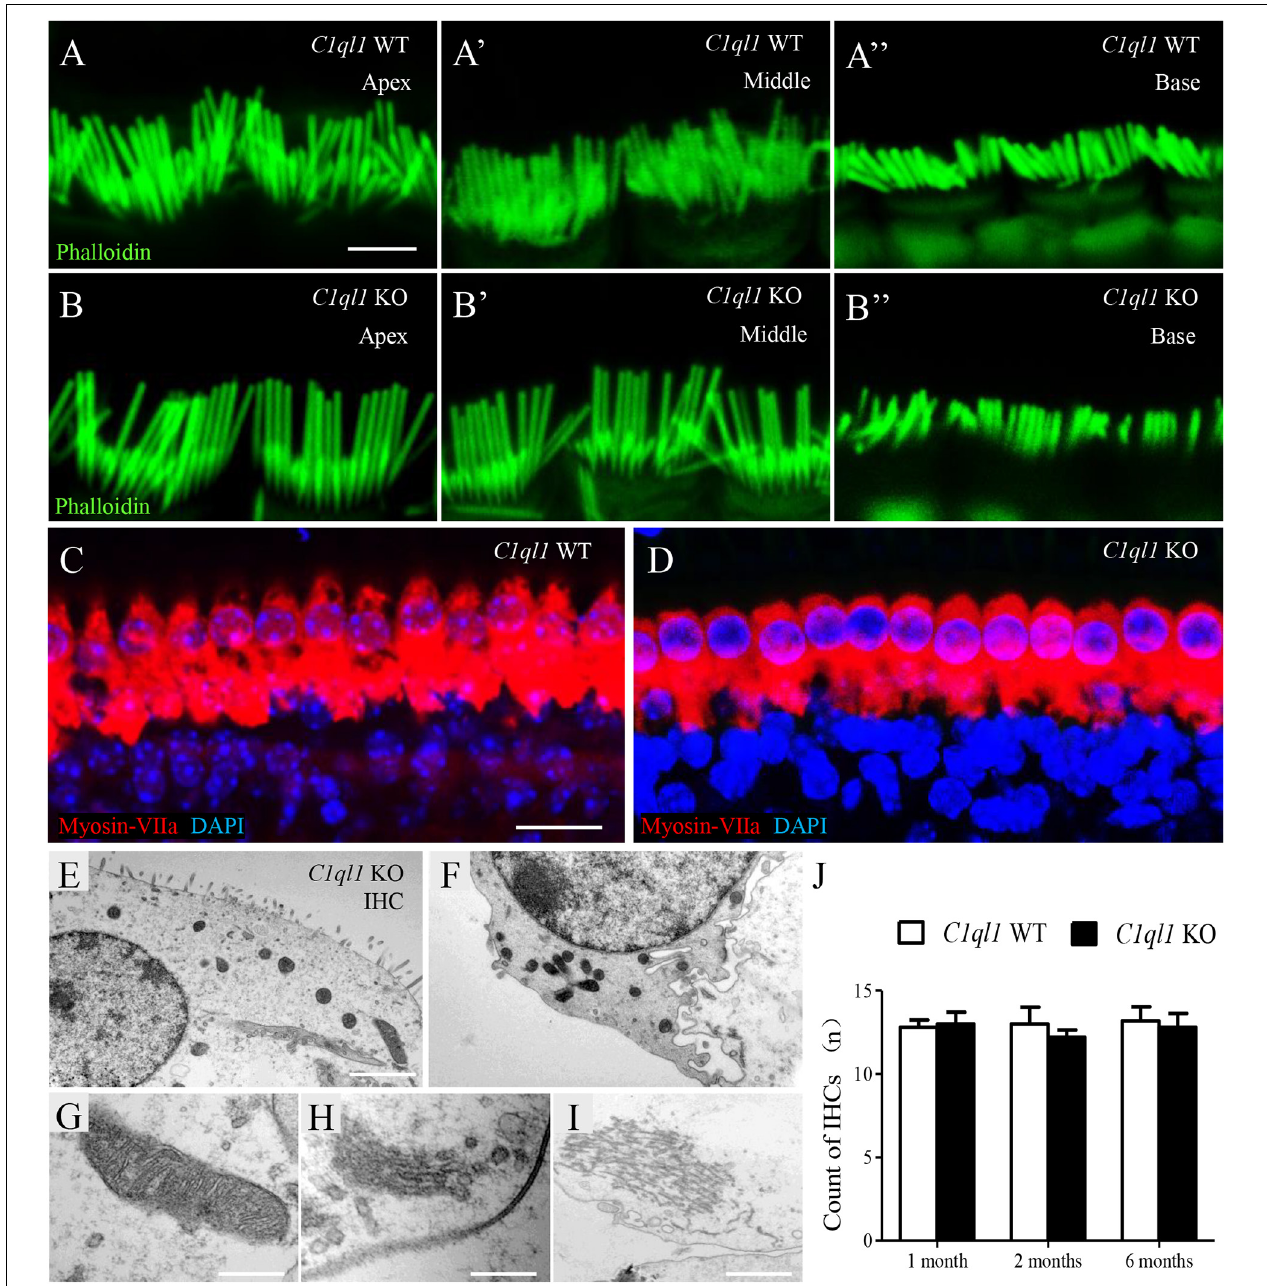
FIGURE 6 | Morphology of cochlear inner hair cells in C1ql1 WT mice and C1ql1 KO mice. (A,B) The stereocilia in apex turn, middle turn and base turn of inner hair cells (green, labeled by phalloidin) in C1ql1 WT mice and C1ql1 KO mice. Scale bar = 2.5 µ m. (C) The normal gross morphology of IHCs in C1ql1 WT mice. (D) The gross morphology of IHCs in C1ql1 KO mice. Cytoplasm of inner hair cells was marked with anti-myosin VIIa antibody (red) and nucleus of cells with DAPI (blue). Scale bar = 10 µ m. (E–I) Subcellular structures of inner hair cells in C1ql1 KO mice, normal mitochondria, Golgi apparatus, and endoplasmic reticulum were showed, respectively. Scale bar = 2.5 µ m (E) . (J) Count of OHCs in C1ql1 WT mice and C1ql1 KO mice in postnatal 1 and 6